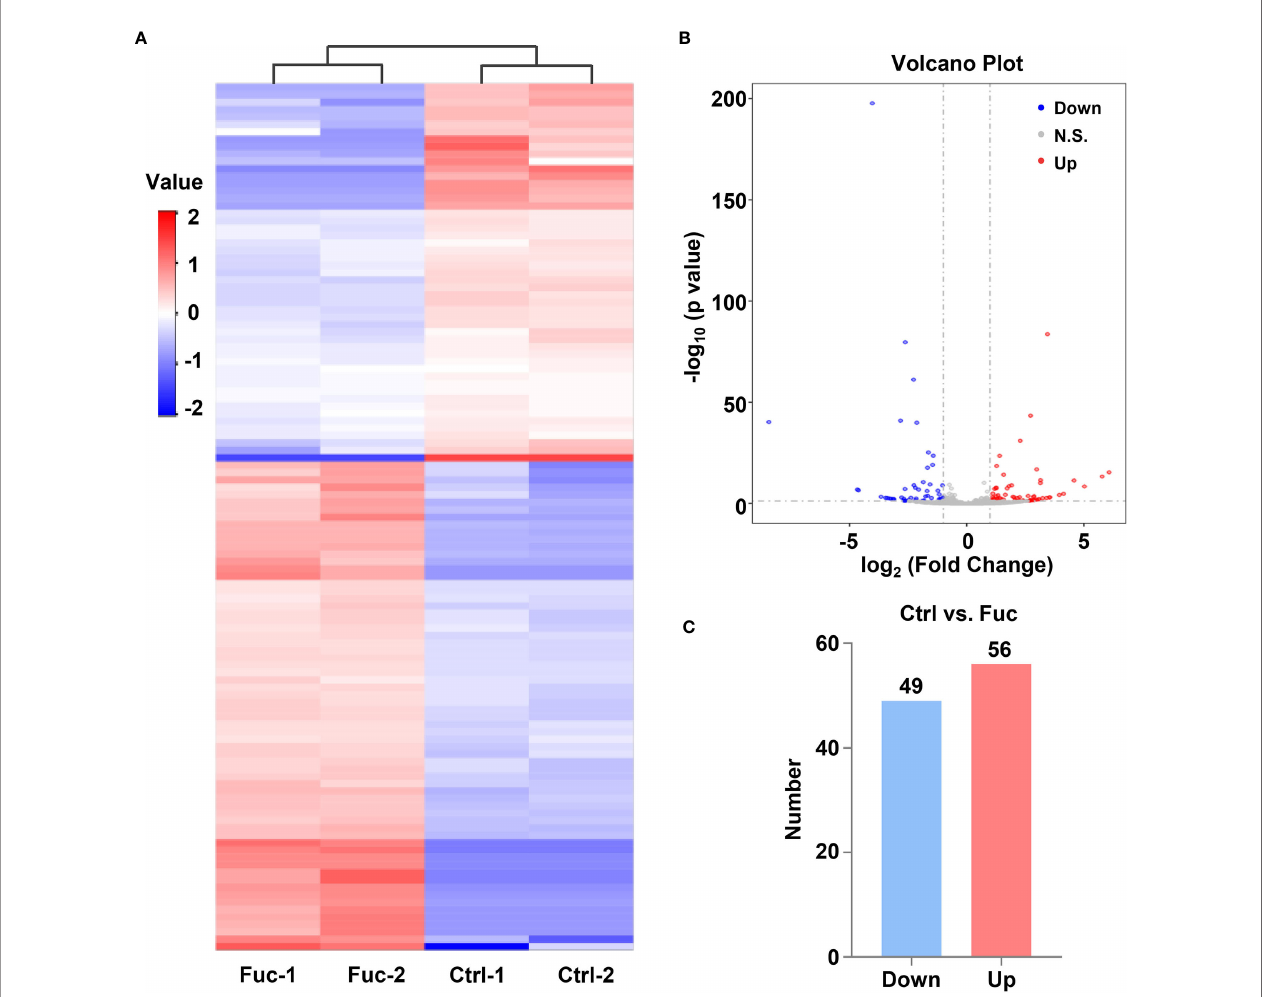
FIGURE 5 | Fucoidan contributes to the alteration of lncRNAs pro fi ling in MHCC-97H cells. (A) Heatmap shows clustering analysis of differentially expressed lncRNAs treated with saline (Ctrl) and 0.5 mg/mL Fuc. Each group had two duplicated experiments. (B) Volcano plots presents signi fi cantly different expression pro fi les of lncRNAs in MHCC-97H cells treated with saline and 0.5 mg/mL Fuc. Vertical lines referred to 2-fold changes in up-regulation and down-regulation. Horizontal line corresponds to p=0.05. Blue and red points represent to down- and up-regulation with statistical signi fi cance. (C) Numbers of signi fi cantly down- and up-regulated lncRNAs in MHCC-97H cells treated with 0.5 mg/mL